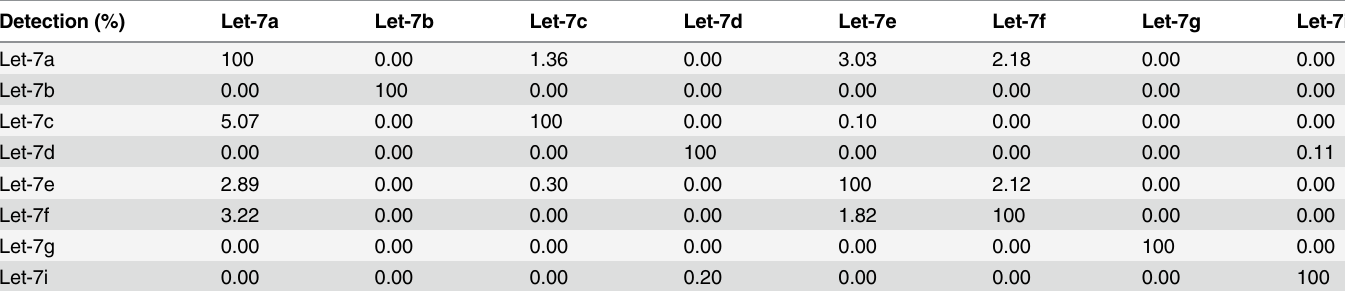
Table 3. Cross reaction (%) of each let-7 miRNAs by speci fi c pincer probe real-time PCR